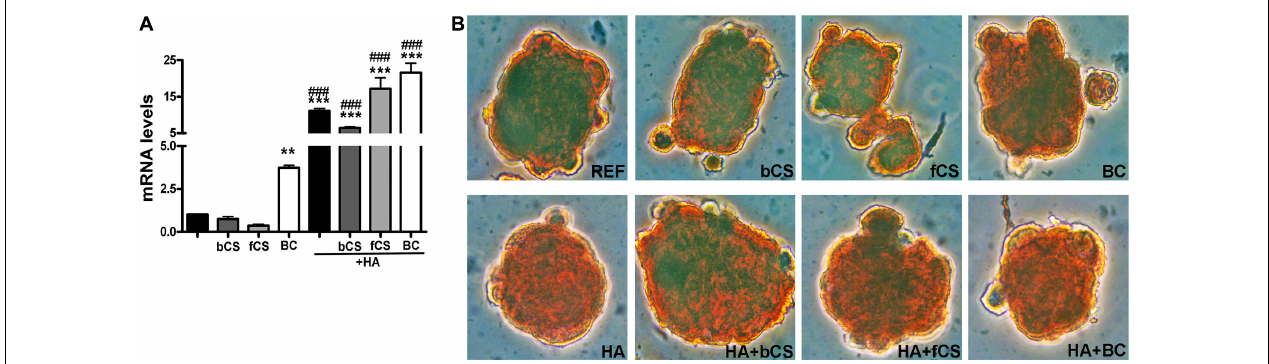
FIGURE 3 | HAS-1 expression and Safranin O staining. (A) The histogram shows the HAS-1 mRNA levels in MSCs induced to chondrocyte differentiation with GAGs in terminal differentiation. Data are normalized to mRNA levels observed in differentiated cultures obtained with the Reference Method. For each mRNA, the expression level observed in reference cultures is set at 1, its decrease or increase in the other experimental conditions is expressed as fold change. Data are reported with standard deviation ( n = 3) (–) stands for no chondroitin supplementation. We compared the gene expression in HA hydrogel with the HA + bCS hydrogel. In each histogram the symbol * indicates the statistical difference between them. We compared the gene expression in bCS hydrogel with the HA + bCS hydrogel. In each histogram the symbol # indicates the statistical difference between them (* < 0.05; ** < 0.01; *** < 0.001; # < 0.05; ## < 0.01; ### < 0.001). (B) Representative images of Safranin O staining on whole-pellet culture samples. In the first row, REF indicates the reference differentiation. All the other experimental conditions were with the procedure we named “GAGs in terminal differentiation.” In the first row, the bCS, fCS, and BC indicate differentiation with three different chondroitin hydrogels. In the second row, the GAG terminal differentiation was performed with HA alone (leftmost) or in combination with the chondroitin